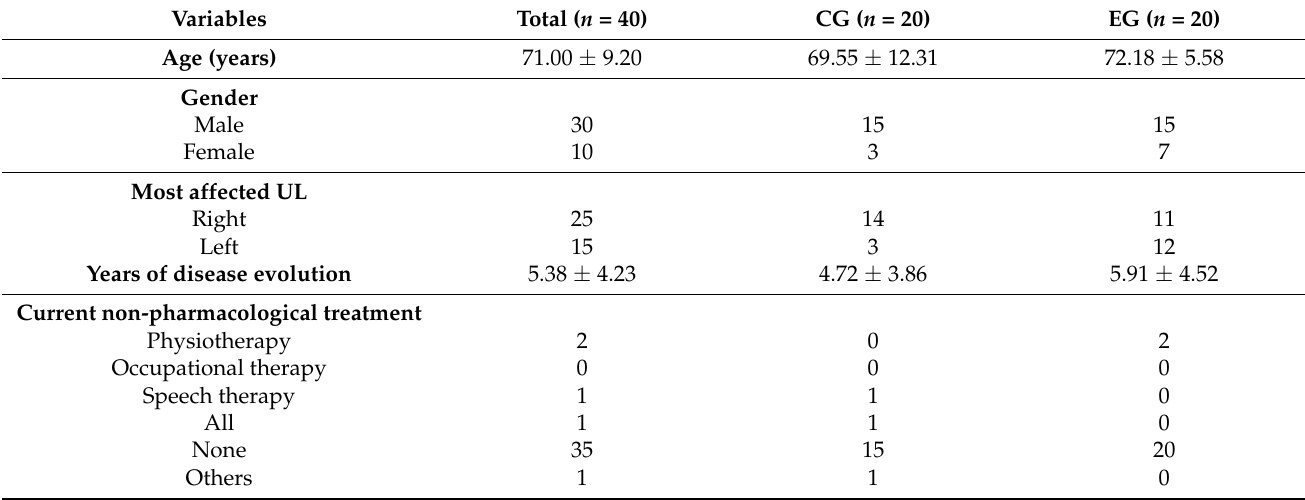
Table 1. Baseline characteristics of participants.